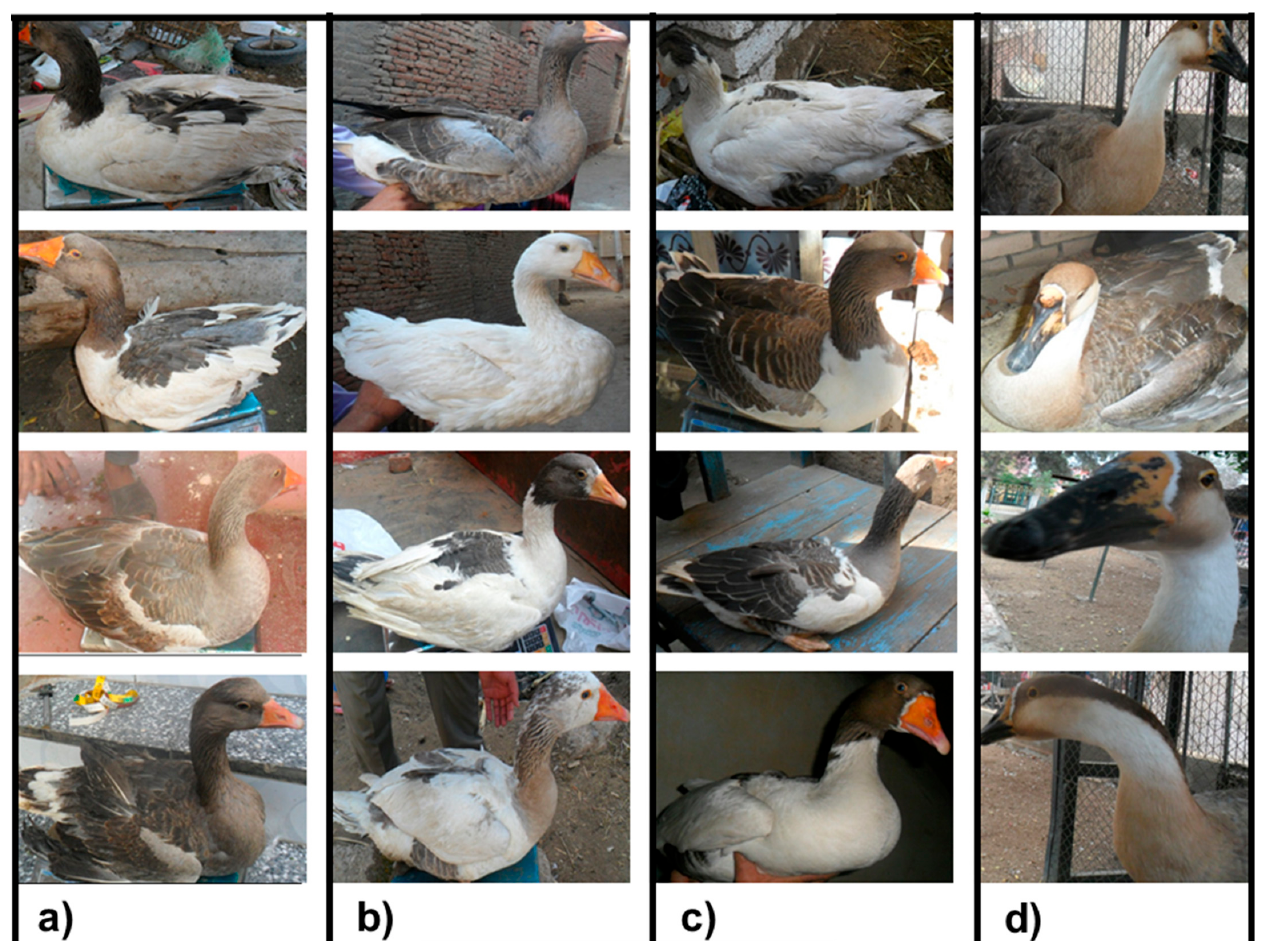
Figure 2. Collected photos of the native Egyptian—( a ) Kafr El-Sheikh, ( b ) Fayoum and ( c ) Luxor—and ( d ) Chinese geese populations.